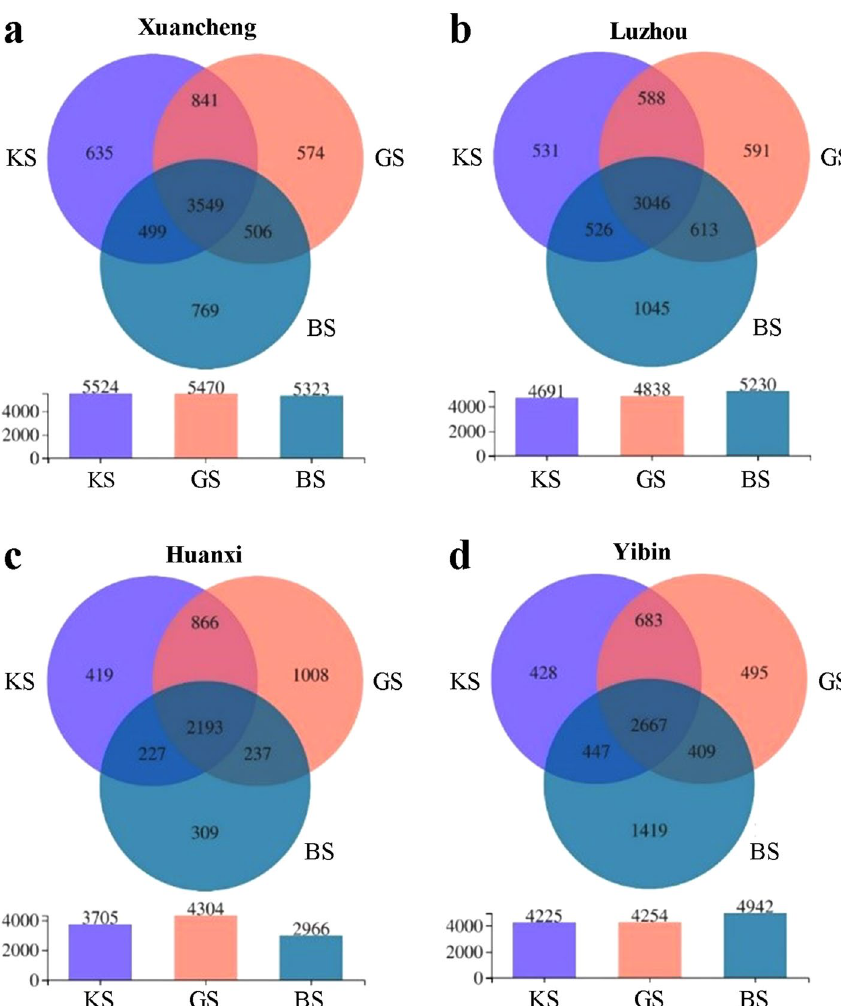
Figure 3. Venn analysis of OTUs among KS, GS and BS in Xuancheng, Luzhou, Huanxi and Yibin. ( a ) Venn analysis of OTUs among KS, GS and BS in Xuancheng. ( b ) Venn analysis of OTUs among KS, GS and BS in Luzhou ( c ) Venn analysis of OTUs among KS, GS and BS in Huanxi. ( d ) Venn analysis of OTUs among KS, GS and BS in